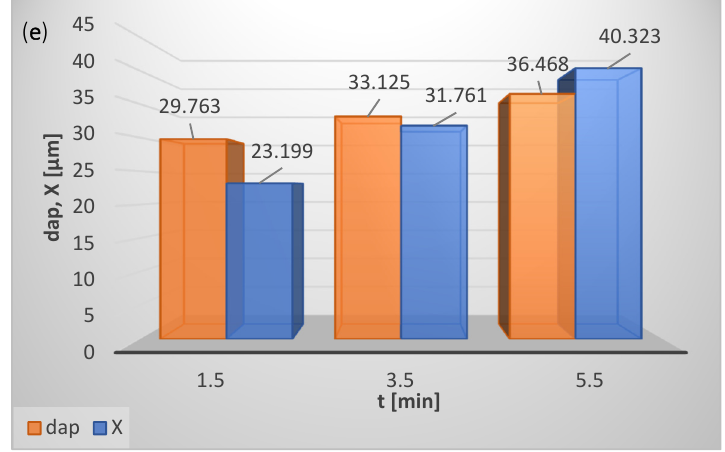
Figure 7. Influence of operating parameters on performance g of classification process and cut size X of product for ( a ) mass of fed material, m f , ( b ) Sauter mean diameter of fed material, d af , ( c ) classifier rotor speed, n, ( d ) working air pressure, p, ( e ) test conducting time, t.